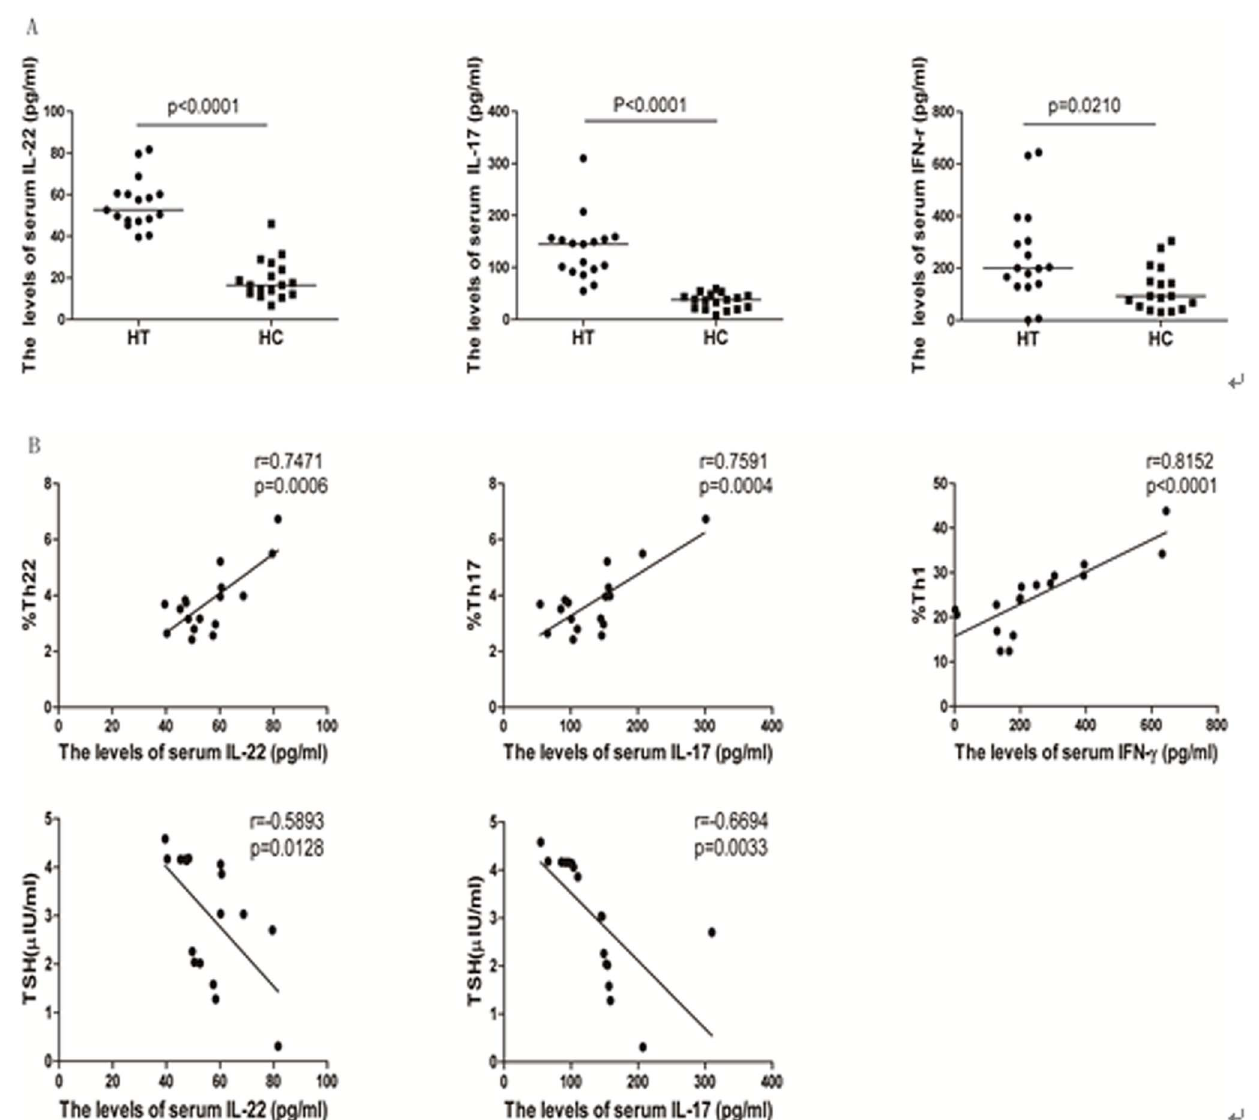
Figure 4. The levels of serum IL-22, IL-17A, and IFN- c in each subject. The levels of serum IL-22, IL-17A, and IFN- c in each subject were measured by ELISA and the potential association of the concentrations of serum cytokines with the percentages of corresponding cells or the levels of serum TSH was analyzed by Spearman’s rank correlation test. Data are expressed as the mean values of individual subjects (n=17 for each group) from four separate experiments. A. ELISA analysis of the levels of serum cytokines; B. Correlation analysis. The levels of serum IL-17A were not significantly correlated with the percentages of Th17/Th22 cells in those patients (data not shown). The levels of serum IL17A and IL-22 were not correlated with the values of other measures tested in the HT patients (data not